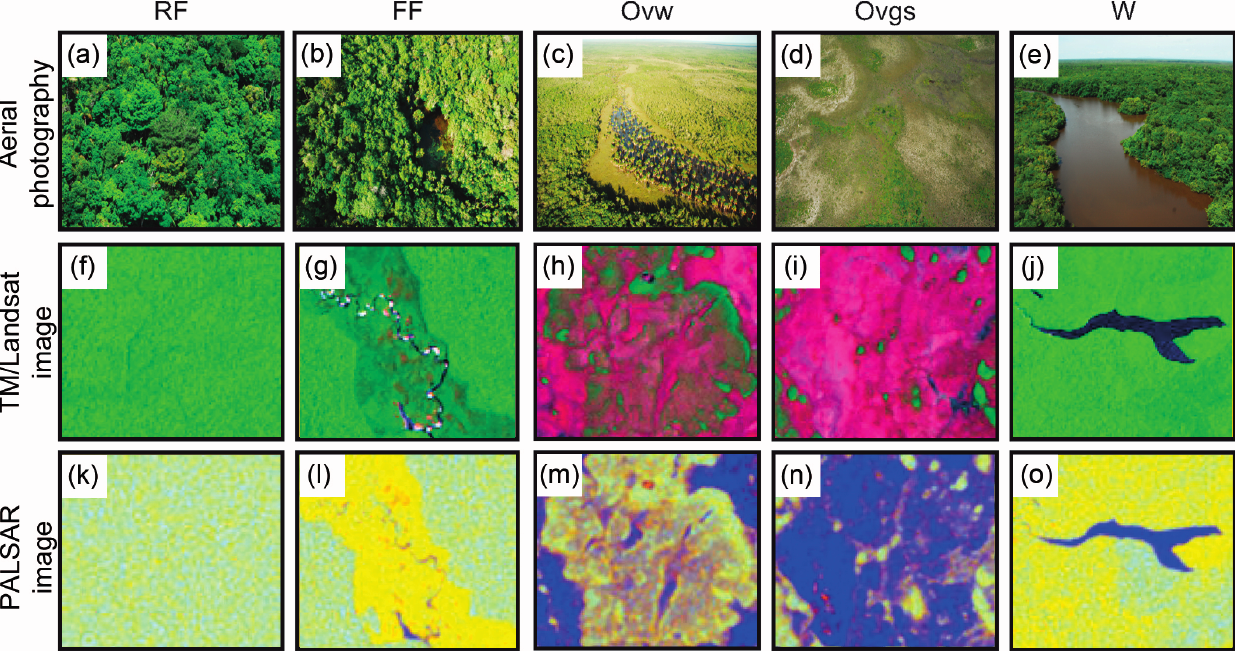
Figure 2. ( a – e ) Aerial photographs illustrating the phytophysiognomic classes of the study area; ( f – j ) TM/Landsat image with composite color in Red (Band 5), Green (Band 4) and Blue (Band 3); ( k – o) PALSAR image with composite color in Red (Band HH), Green (Band HV) and Blue (Ratio HH/HV) (RF = Rainforest; FF = Flooded forest; Ovw = Wooded open vegetation; Ovgs = Grassy-shrubby open vegetation; W = Open water